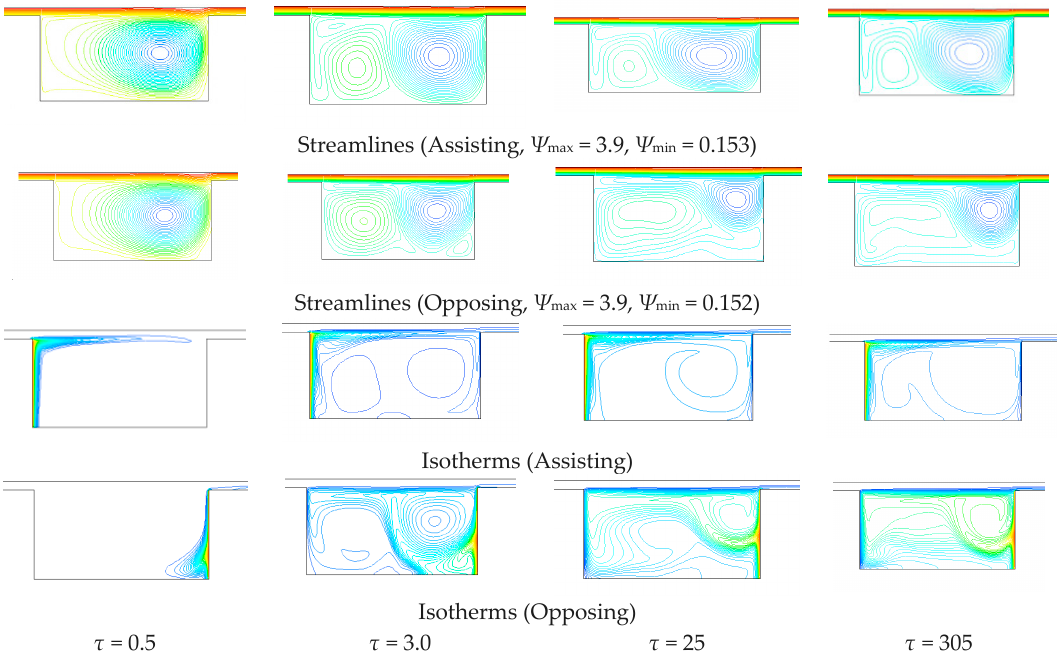
Figure 7. Streamlines and isotherms for Re = 1000, aspect ratio (AR) = 2.0 and Ri = 6.54.